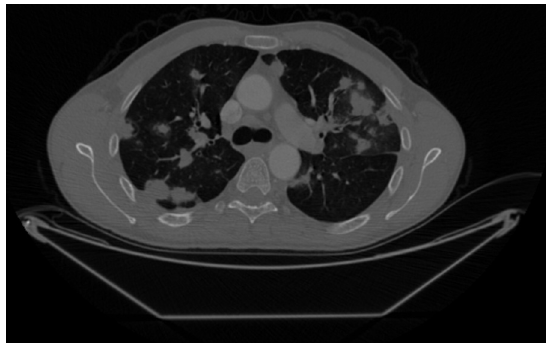
intraparenchymal and subpleural metastatic nodules in the thorax CT of the first